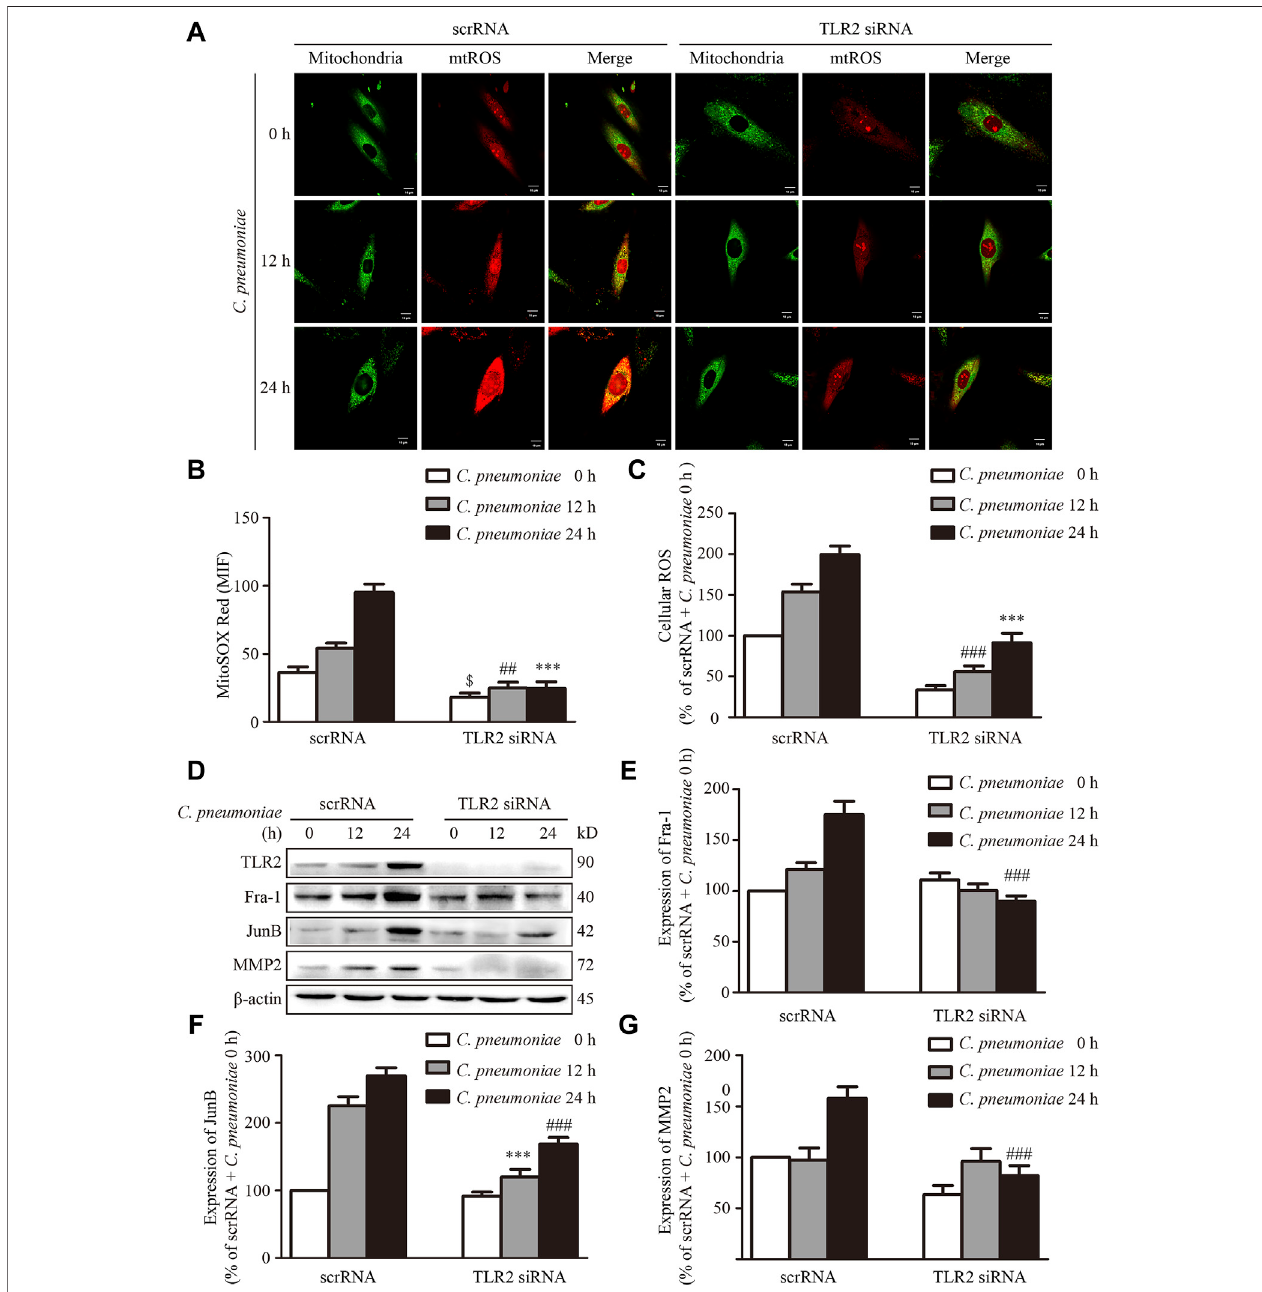
FIGURE7| TLR2regulatestheexpressionsofFra-1,JunBandMMP2inVSMCsafter C.pneumoniae infection invitro .VSMCswerepretreatedwithTLR2speci fi c siRNA and infected with C. pneumoniae for the indicated timepoints. (A) Representative confocal microscopy images of VSMCs were stained with MitoSOX Red and Mito-TrackerGreenafter C.pneumoniae infection. Scale:10 μ M. (B) Quanti fi cation ofMitoSOXRed fl uorescence intensityinVSMCs. $ p < 0.05,compared withscrRNA + C. pneumoniae infection 0 h group, as analyzed by Student ’ s t -test. ## p < 0.01, compared with scrRNA + C. pneumoniae infection 12 h group, as analyzed by Student ’ s t -test. *** p < 0.001, compared with scrRNA + C. pneumoniae infection 24 h group, as analyzed by Student ’ s t -test. (C) Quanti fi cation of the level of cellular ROS in VSMCs infected with C. pneumoniae for the indicated timepoints. ## p < 0.01, compared with scrRNA + C. pneumoniae infection 12 h group, as analyzed by Student ’ s t -test.*** p < 0.001,comparedwithscrRNA+ C.pneumoniae infection24 hgroup,asanalyzedbyStudent ’ s t -test. (D) RepresentativeWesternblotimagesof TLR2, Fra-1, JunB and MMP2 from VSMCs pretreated with TLR2 speci fi c siRNA and infected with C. pneumoniae for the indicated timepoints. (E – G) The expression ratio of Fra-1 (E) or JunB (F) or MMP2 (G) to β -actin from three independent experiments is presented. *** p < 0.01, compared with scrRNA + C. pneumoniae infection 12 h group, as analyzed by Student ’ s t -test. ### p < 0.001, compared with scrRNA + C. pneumoniae infection 24 h group, as analyzed by Student ’ s t -test.